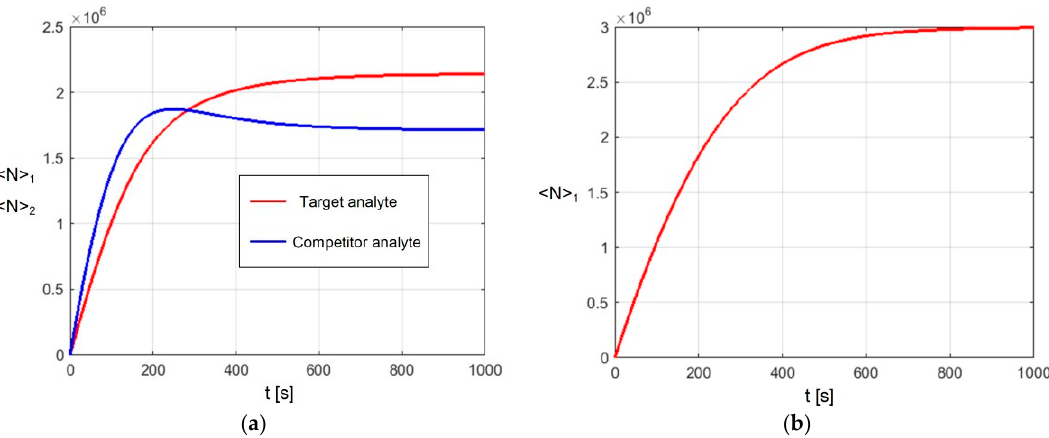
Figure 1. ( a ) Time dependent expected value of the adsorbed particles number of the target (red line) and the competitor analyte (blue line), obtained by using the stochastic response model; ( b ) Expected number of adsorbed particles when only the target analyte is present in the analyzed